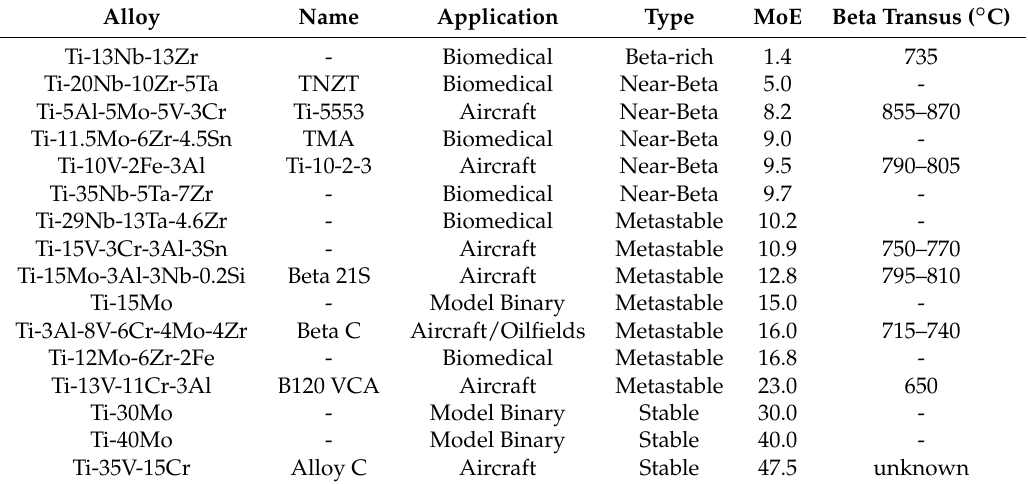
Table 2. The molybdenum equivalency (MoE) and beta transus temperatures ( T β ) of several model binary and commercially important beta Ti alloys. Compositions of the alloys are given in wt.